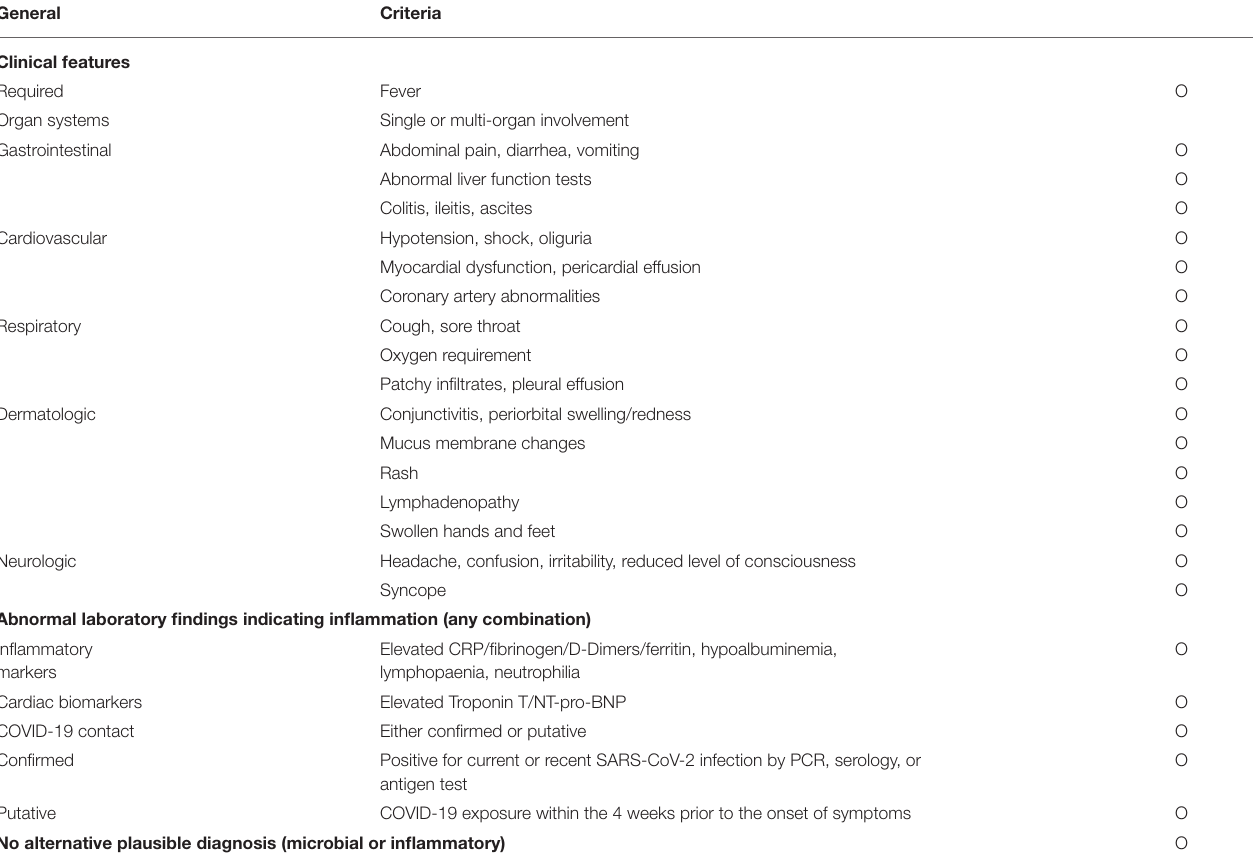
TABLE 1 | List of diagnostic criteria for PIMS-TS.